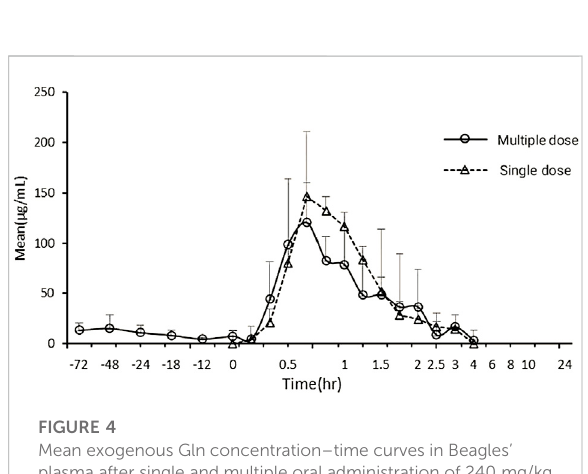
FIGURE 4 Mean exogenous Gln concentration – time curves in Beagles